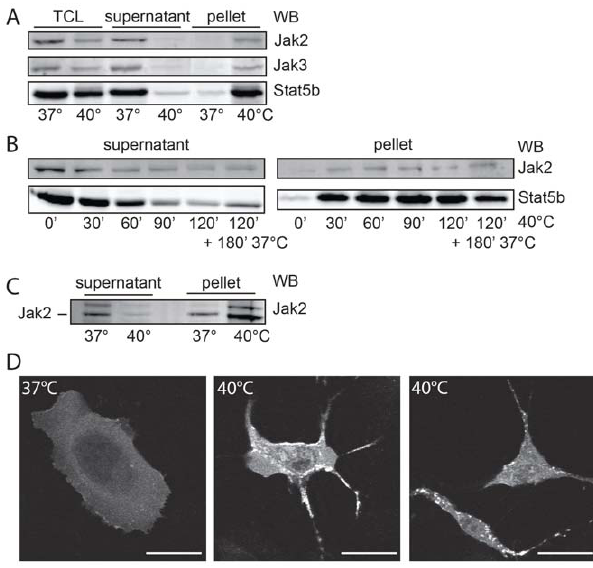
Figure 3. Thermal stress induces both Jak2 degradation and aggregation. ( A ) Equal amounts of isolated PBMCs were incubated at 37 u C and 40 u C, respectively, for 4 h. The cells were either lysed in 1% SDS and analyzed in western blot (TCL) or lysed in 1% NP-40; the lysates were centrifuged (500 g), the supernatants were collected and the pellets were dissolved in 1% SDS. Equal aliquots were analyzed by western blotting (WB) using anti-Jak2, anti-Jak3 and anti-STAT5b antibodies. ( B ) Equal amounts of isolated PBMCs were incubated at 40 u C for the indicated times, lysed in 1% NP-40, and analyzed as in Fig. 3A (WB) using anti-Jak2 and anti-STAT5b antibodies. For the right lanes in the four panels, the incubation was continued for 3 h at 37 u C. ( C ) Equal amounts of Hek293-TR cells were lysed in 1% Triton X-100, the lysates were clarified by centrifugation, and incubated at 37 u C and 40 u C, respectively, for 4 h. Next, the lysates were centrifuged at 500 g, and equal aliquots of supernatant and pellet were analyzed by western blotting (WB), using anti-Jak2 antibody. The upper band is an unspecific background band. ( D ) c 2A Jak2 2 / 2 cells, transfected with GFP-Jak2, were incubated at 37 and 40 u C for 4 h and fixed in formaldehyde. Representative pictures are shown. Fluorescence was visualized with a confocal microscope. Bar, 20 m m. All data in this figure are represen-